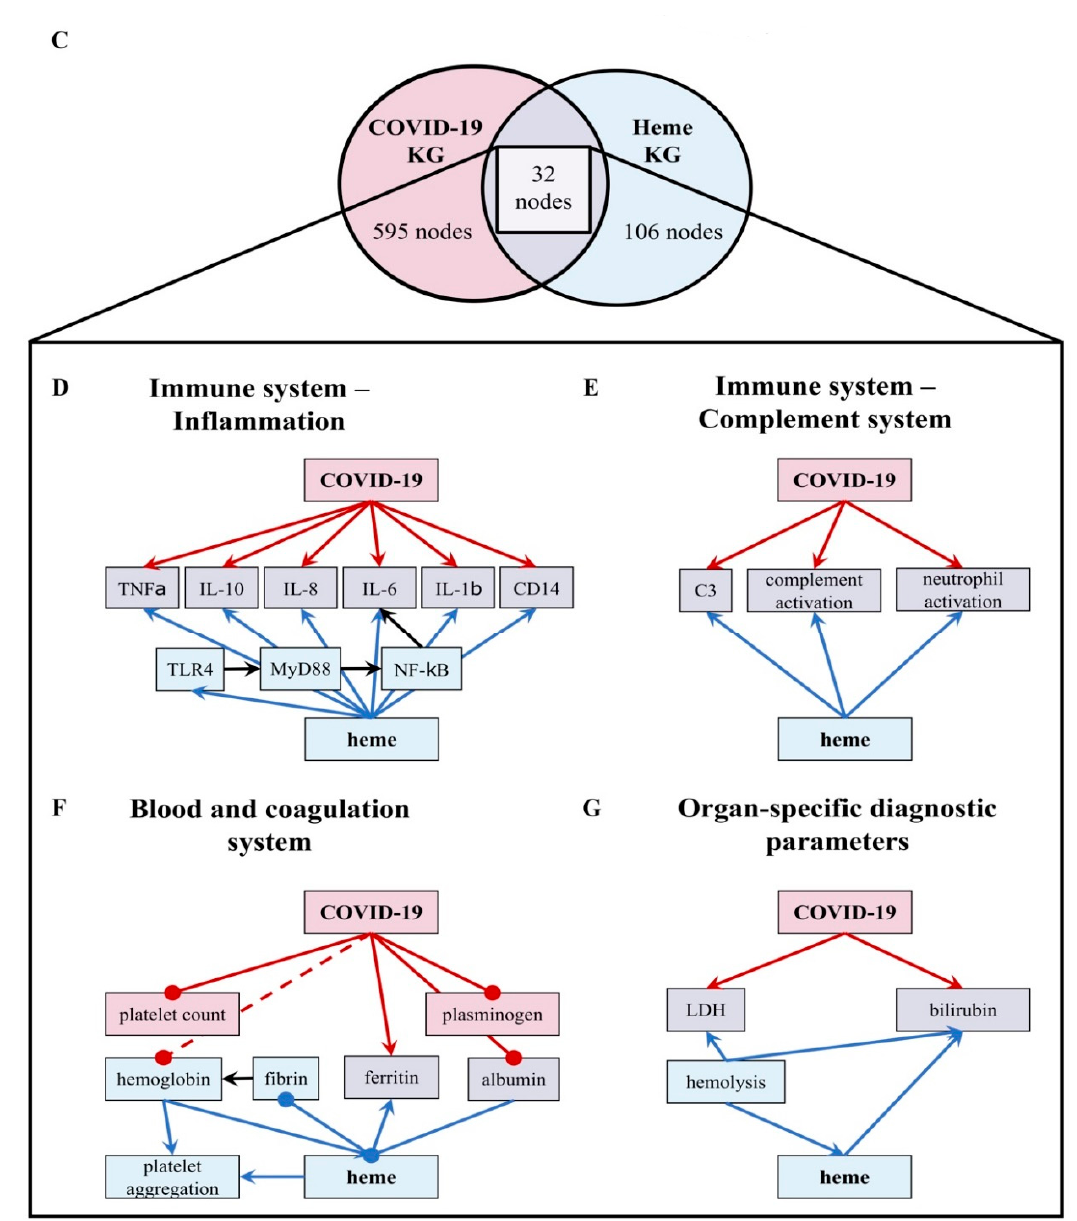
Figure 1. The overlap between the COVID-19 KG [54] and Heme KG [42] reveals shared biochemical pathways. ( A ) The network displays the largest area of overlap between the two KGs. Node coloring denotes whether a particular entity is present exclusively in the COVID-19 KG (blue), in the Heme KG (green), or in both (red). Neighbors of overlapping nodes are colored in light red. The parts of the network corresponding to inflammation, blood coagulation, and complement system are circled. ( B ) A high-resolution network view of the inflammation system with directionality of the relations (small excerpt depicted). Solid edges represent increase and decrease relations, while dashed edges represent correlations. ( C ) The overlap between the two KGs based on human proteins represented as a Venn diagram. The numbers of nodes that only present proteins are depicted (COVID-19 KG: 595 (red), Heme KG: 106 (blue), overlap between both: 32 (violet)). The two KGs overlapped in the following systems: immune response–inflammation (panel ( D )), immune response–complement system (panel ( E )), blood and coagulation system (panel ( F )), and organ-specific diagnostic markers (panel ( G )). The hemoglobin level was often decreased in COVID-19 patients [29,59] and is depicted (dashed, red line). ATP: adenosine triphosphate, C3: complement component 3, CRP: C-reactive protein, DPP4: dipeptidyl peptidase 4, HAS2: hyaluronan synthase 2, Hx: hemopexin, IL: interleukin, LDH: lactate dehydrogenase, NKAP: NF- κ B-activating protein, PDCD1: programmed cell death protein 1, RIPK3: receptor interacting serine/threonine kinase 3, ROS: reactive oxygen species, and TLR4: Toll-like receptor